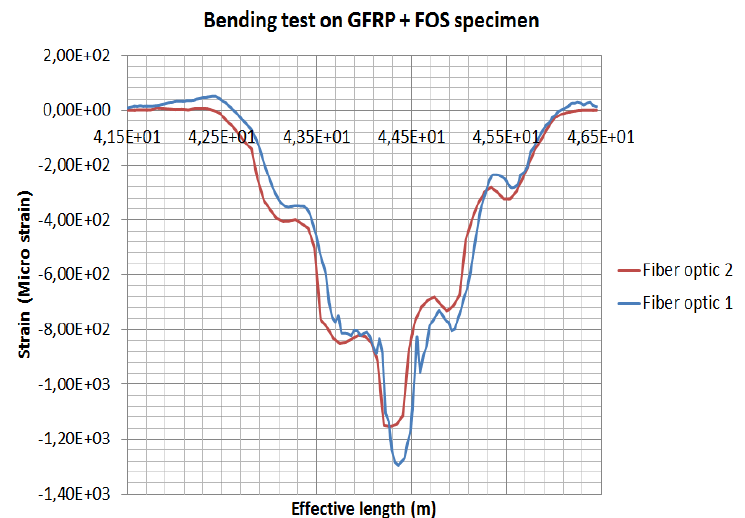
Figure 15. Bending strain measurement carried out with dual-sinusoidal FOSs alignment on glass-fiber composite specimen.